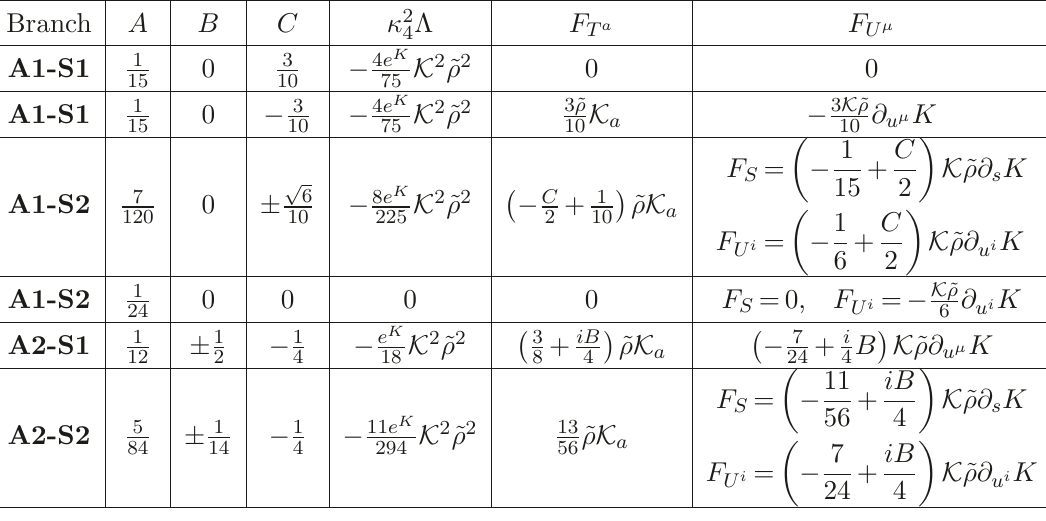
Table 1 . Different branches of solutions with the corresponding vacuum energy and F-terms. The solutions in the branch S2 assume the K¨ahler potential